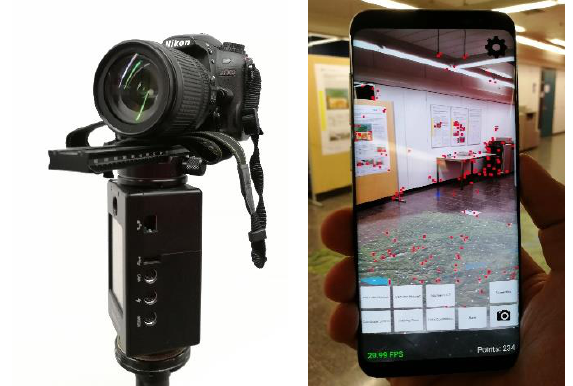
Figure 3. Nikon D7000 with Roundshot panoramic tripod (left) and our ARCore application